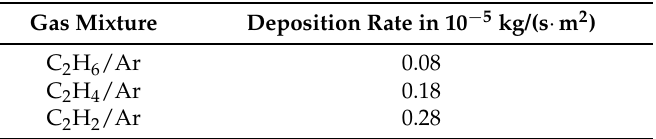
Table 1. Mean deposition rates for different precursor